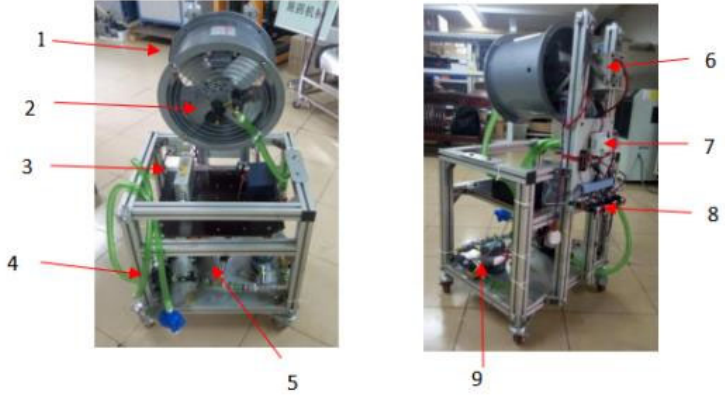
Figure 1. Self-developed axial-flow air-assisted platform: ( 1 ) axial fan; ( 2 ) nozzle; ( 3 ) power supply; ( 4 ) pump; ( 5 ) manometer; ( 6 ) frequency converter; ( 7 ) fan switch; ( 8 ) button; ( 9 ) flow meter.